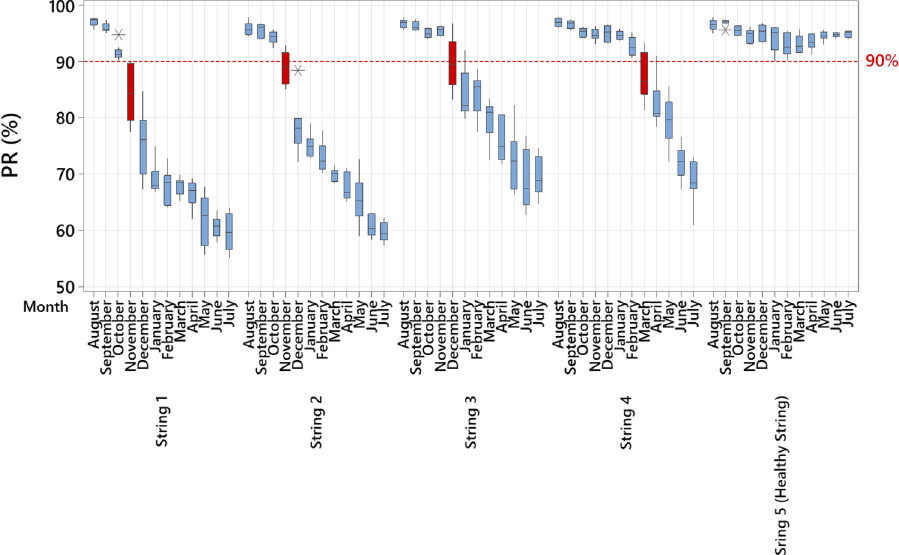
Figure 2. Performance ratio of the tested PV strings. The y-axis presents the PR ratio, and the baseline of 90% was selected to indicate low performance; the x-axis gives the month. This chart shows the PR ratio for the PV strings during their first year of operation and the red labelled boxplots for the individual PV strings believed to be the starting month of the